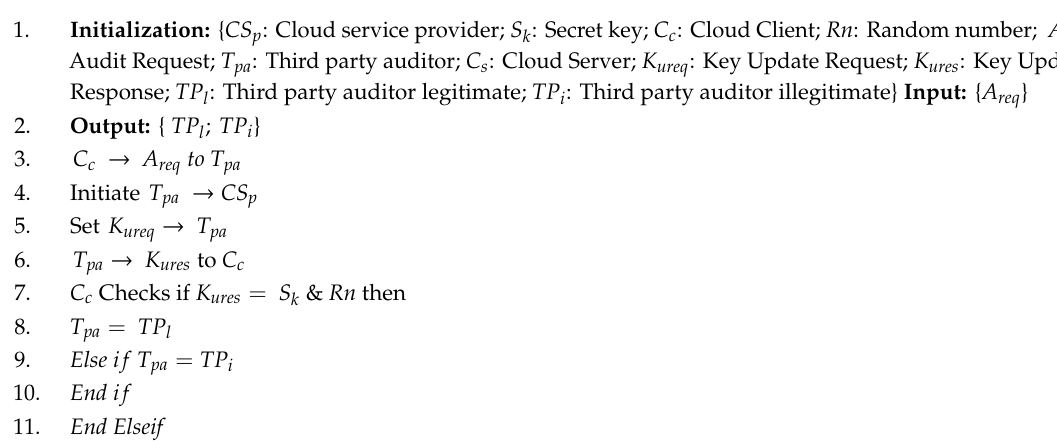
Algorithm 2. Validation of the malicious role of